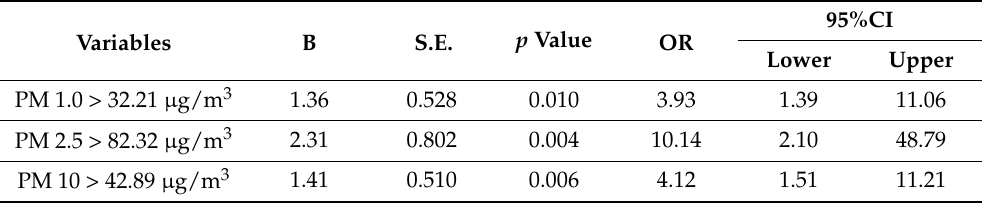
Table 5. Univariate logistic regression analysis of PM values.